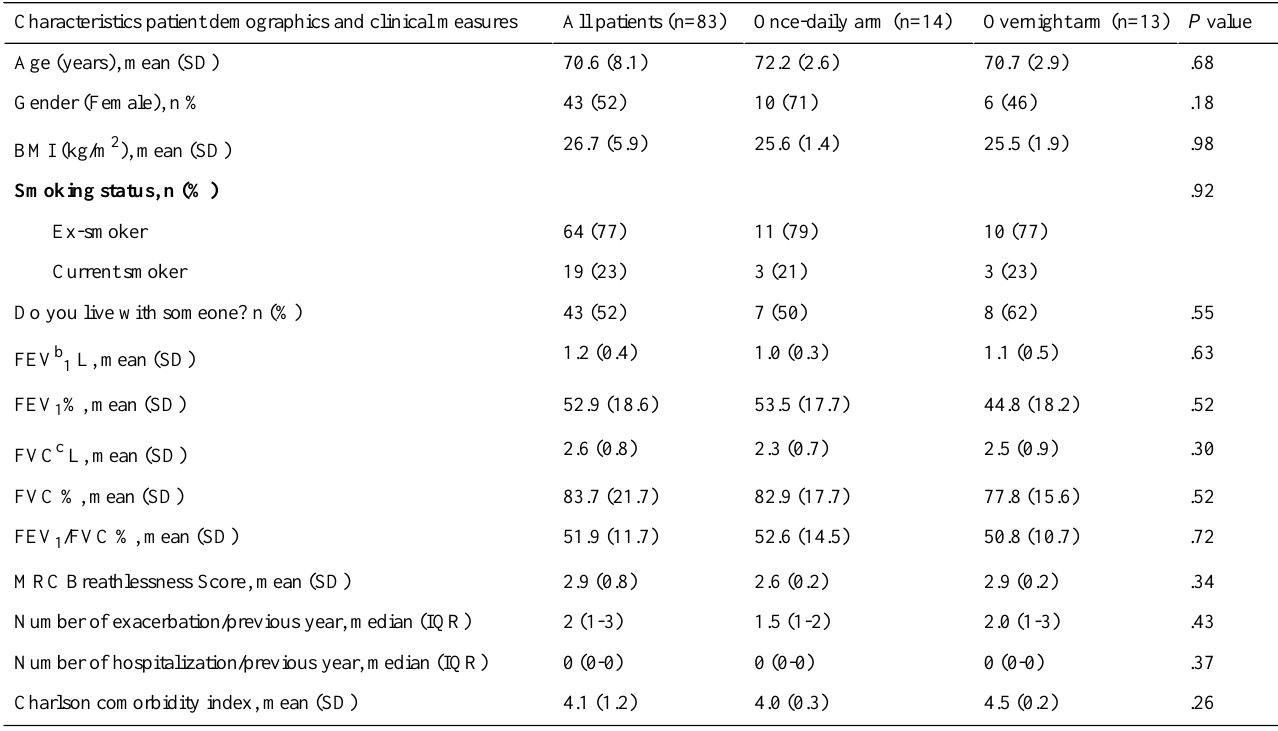
Table 1. Patient demographics and clinical measures.